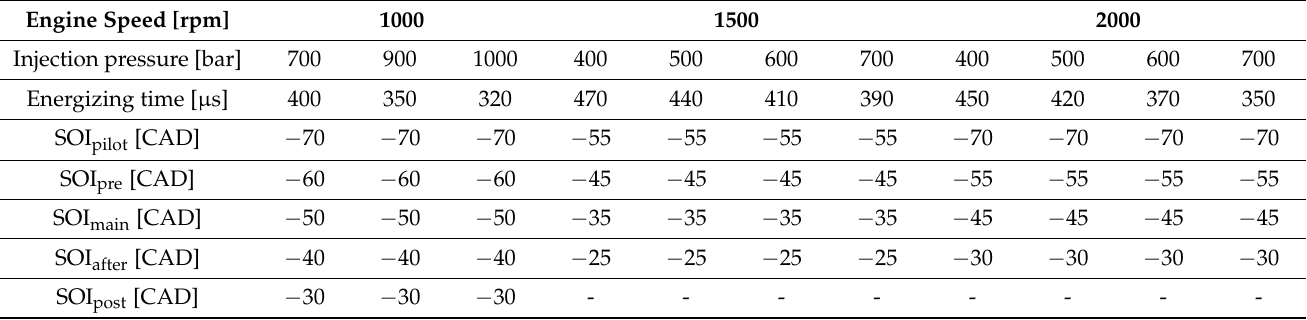
Table 2. Engine operating conditions when the engine speed is fixed at 1000, 1500, and 2000